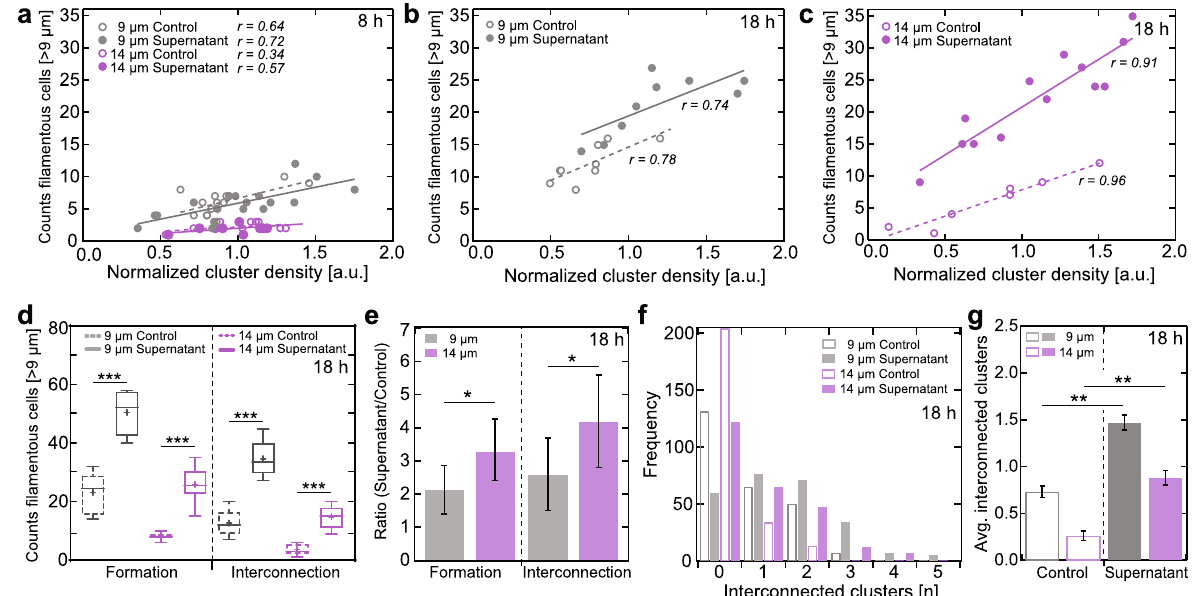
Fig. 5 Supernatant extract decreases cluster distance- and density-dependency in the formation of fi lamentous cells. a Number of fi lamentous cells in dependency of cluster density after 8 h growth in the absence (control) and addition of 2% (v/v) supernatant (SN) after 4 h for 9 and 14 µm distances. b , c Same as ( a ), but with a growth time of 18 h and the addition of SN after 9 h for b 9 µm and c 14 µm distances; analyzed as in Fig. 3d. d Number of fi lamentous cells (Formation) and cluster-interconnecting cells (Interconnection) for 9 and 14 µm distances ( N = 5 images each), grown for 18 h in absence (control) and addition of 2% (v/v) of SN after 9 h. Legend for box and whisker plot: the centerline denotes the median value (50th percentile), the cross the mean average, the bounds of box contain the 25th to 75th percentiles, the whiskers mark the 1.5 interquartile range. e Ratio (mean ± s.d.) of the number of fi lamentous cells (Formation) and cluster-interconnecting cells (Interconnection) in the absence (control) and addition of 2% (v/v) of SN after 9 h for 9 and 14 µm distances, extracted from ( d ). f Degree of interconnected clusters ( N = 256 for each shown data set) and g average number (mean ± 95% con fi dence interval) of cluster interconnections of 9 and 14 µm distances after 18 h growth in absence (control) and addition of 2% (v/v) SN after 9 h. Asterisks indicate statistical signi fi cance (* p < 0.05; ** p < 0.01; *** p < 0.001; n.s. = non-signi fi cant), resulting from two-tailed, unpaired t